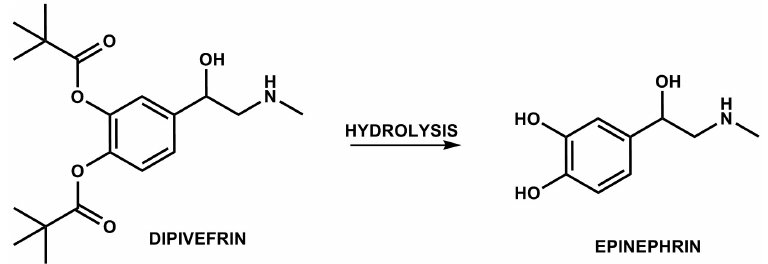
FIGURE 29 - Enzymatic conversion of dipivefrin into its active metabolite, epinephrin